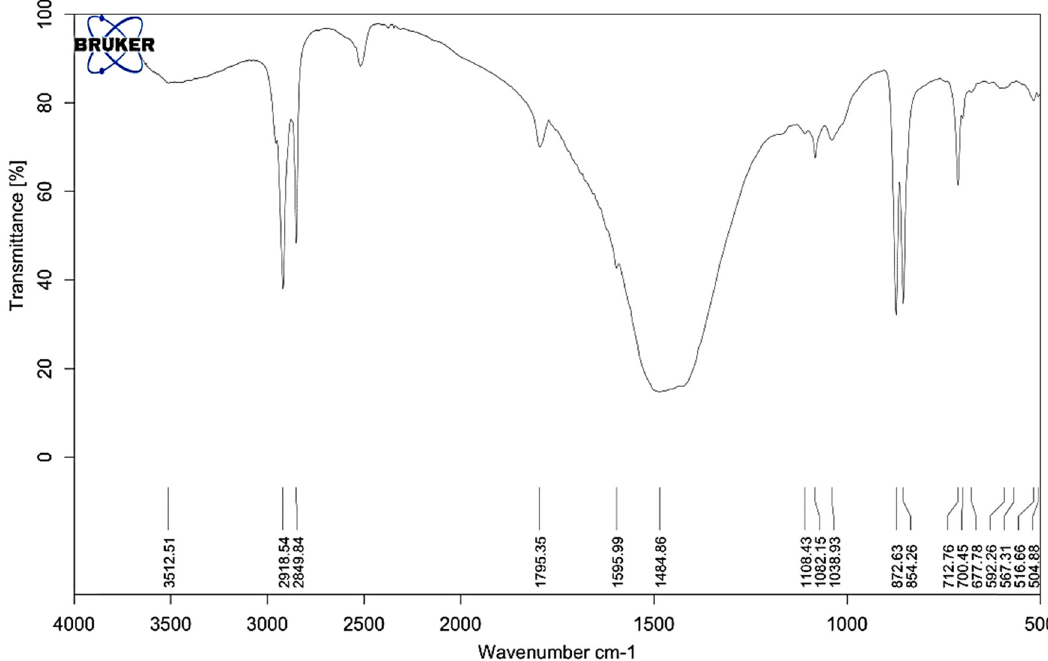
Figure 2: FTIR spectrum of h - BN.